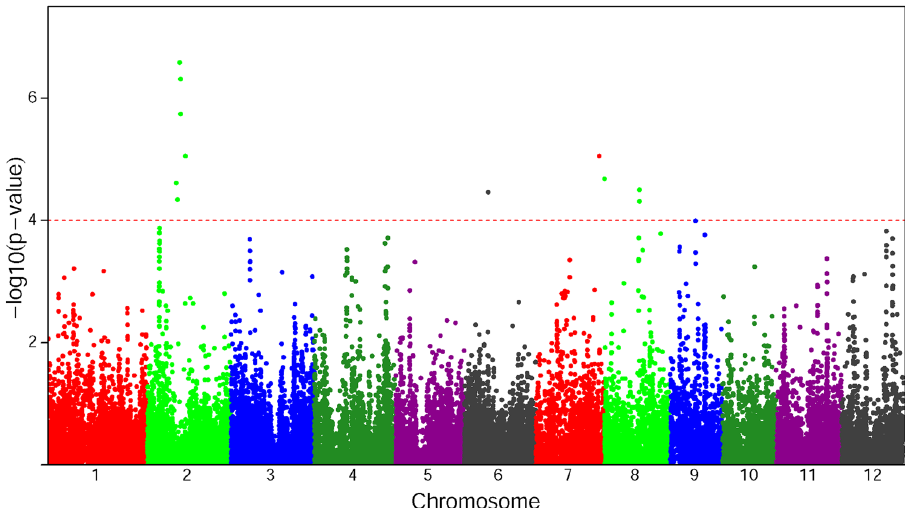
Figure 4. Manhattan plot using robust GWAS (rGWAS) on the trait of rice flowering time. The x-axis is the genomic position of the SNPs in the genome, and the y- axis is -log 10 of the p -values. Each chromosome is colored differently. The grey horizontal line represents the minimal significant level at the cutoff.